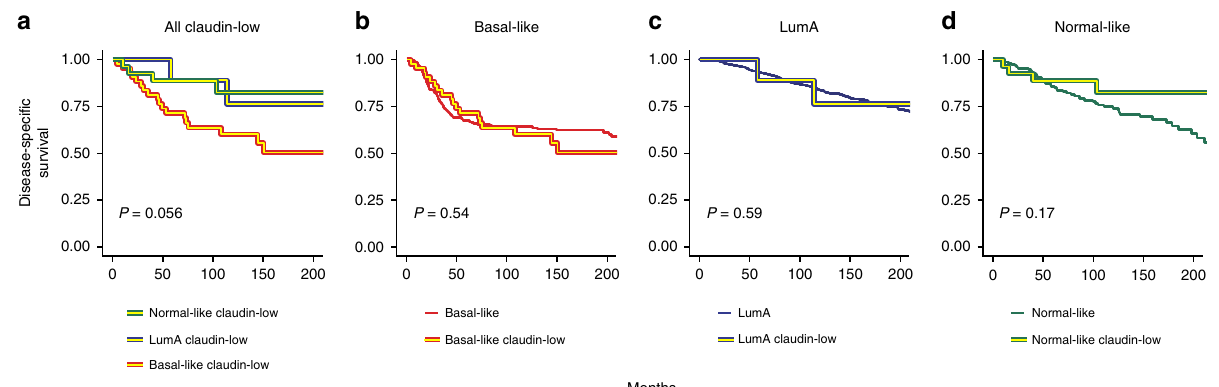
Fig. 2 No evidence of claudin-low status as an indicator of poor prognosis in the METABRIC cohort. a Disease-speci fi c survival in basal-like claudin-low, LumA claudin-low, and normal-like claudin-low tumors in the METABRIC cohort. Survival trends recapitulated the patterns seen in non-claudin-low tumors. P = 0.056 when testing for difference between claudin-low tumors strati fi ed by intrinsic subtype. b – d Disease-speci fi c survival in claudin-low and non- claudin-low basal-like ( b ), LumA ( c ) and normal-like ( d ) tumors. Signi fi cant differences between claudin-low and non-claudin-low tumors were not found (basal-like P = 0. 54, LumA P = 0.59, normal-like P = 0.17). All Two-tailed log-rank test used for signi fi cance testing. Disease-speci fi c deaths and sample sizes: basal-like claudin-low n = 19 of 45, basal-like non-claudin-low n = 98 of 263, LumA claudin-low n = 3 of 9, LumA non-claudin-low n = 144 of 684, normal-like claudin-low n = 5 of 28, normal-like non-claudin-low n = 50 of 155. Source data are provided as a Source Data fi claudin-low tumors (Fig. 3; P = 0.006, SigClust 22 ). We refer to